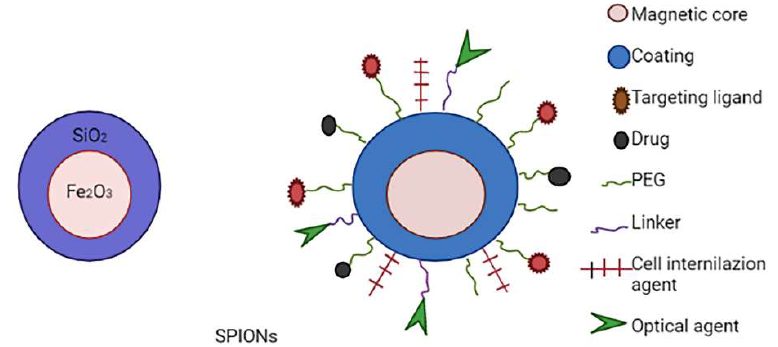
Figure 8. Schematic representation of multifunctional SPIONs.